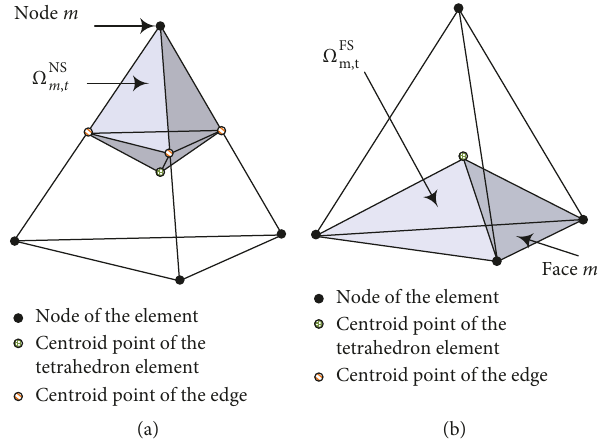
Figure 1: Node-based and (a) face-based (b) smoothing domains constructed based on the tetrahedron